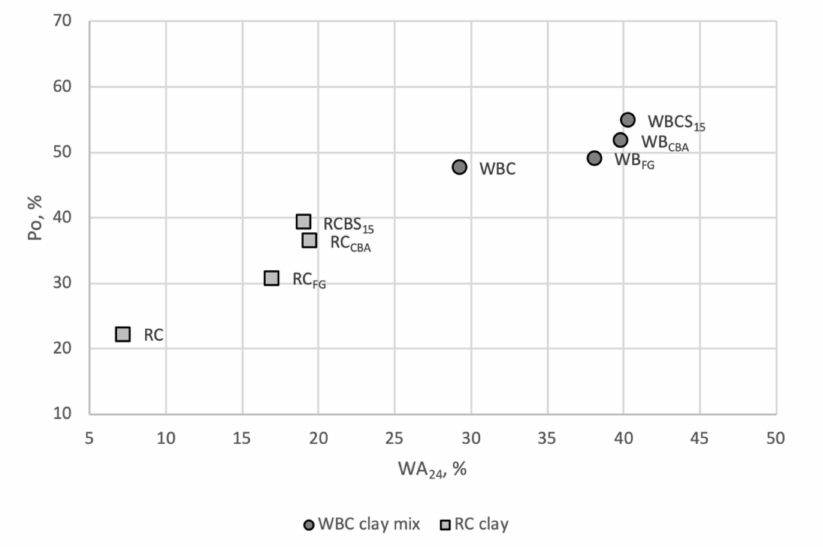
Figure 6. Open porosity (Po) vs. WA 24 representation for the series of aggregates